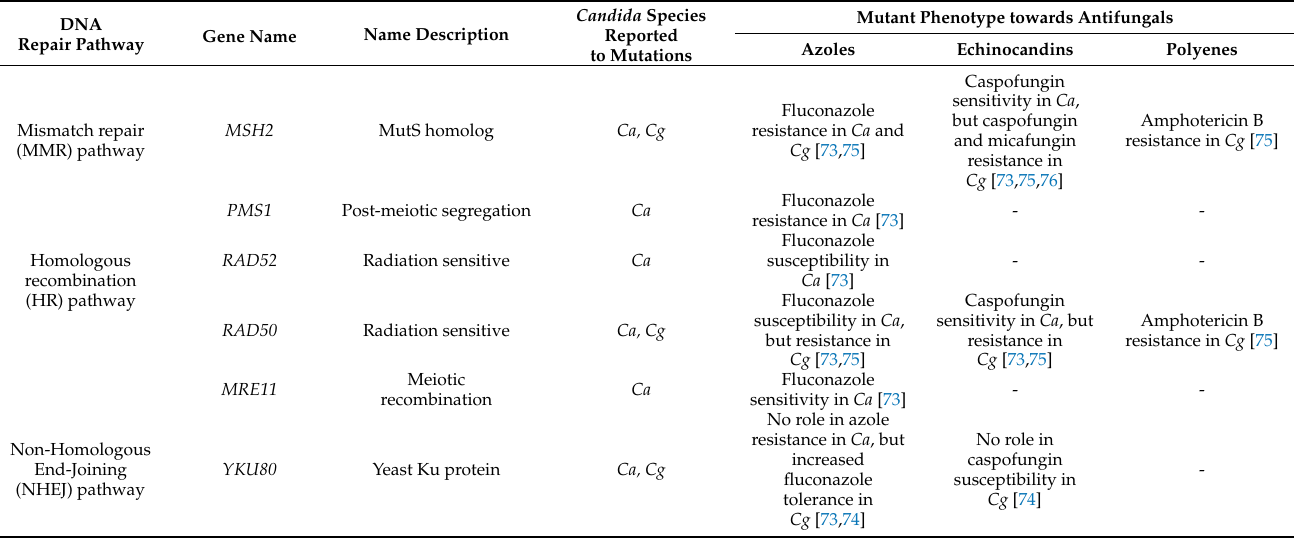
Table 4. DNA-damage repair genes implicated in antifungal drug resistance in C. albicans ( Ca ) and C. glabrata ( Cg